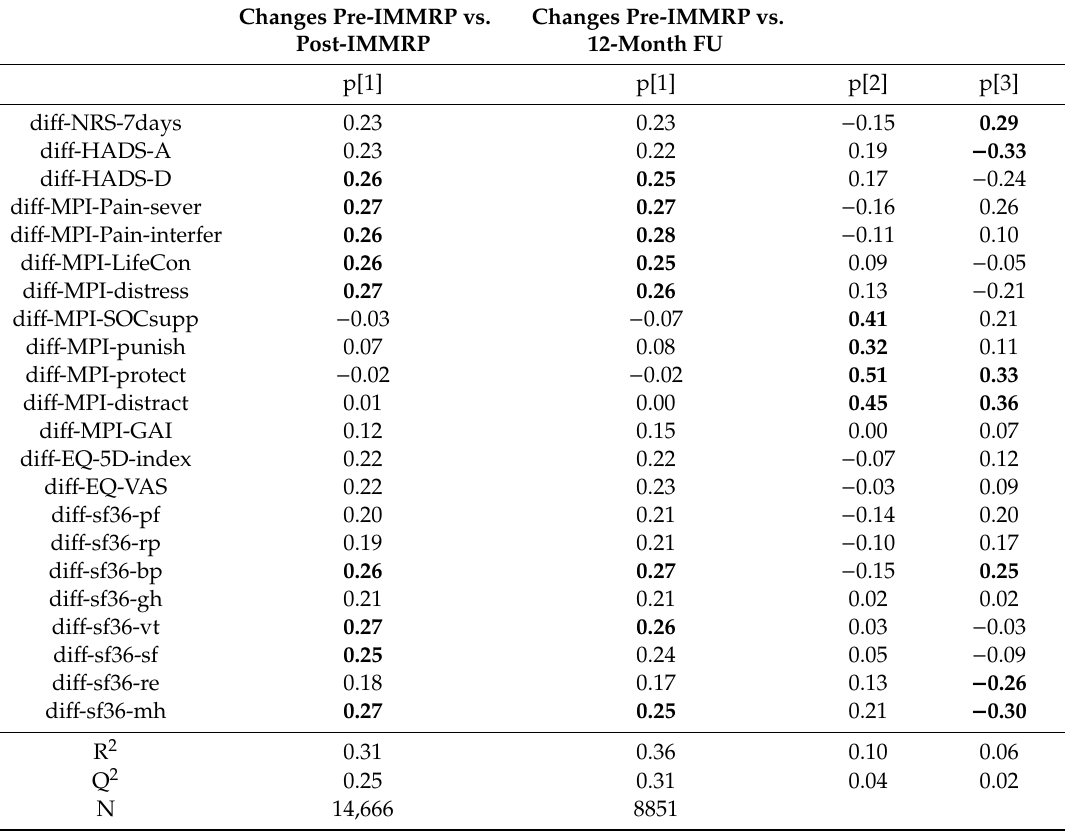
Table 5. Principal component analysis (PCA) of changes pre-IMMRP vs. post-IMMRP (left part) and pre-IMMRP vs. 12-month FU (right part). The significant components (p) are shown. Absolute loadings ≥ 0.25 are shown in bold to facilitate interpretation. Changes in outcomes are calculated so that a positive value indicates an